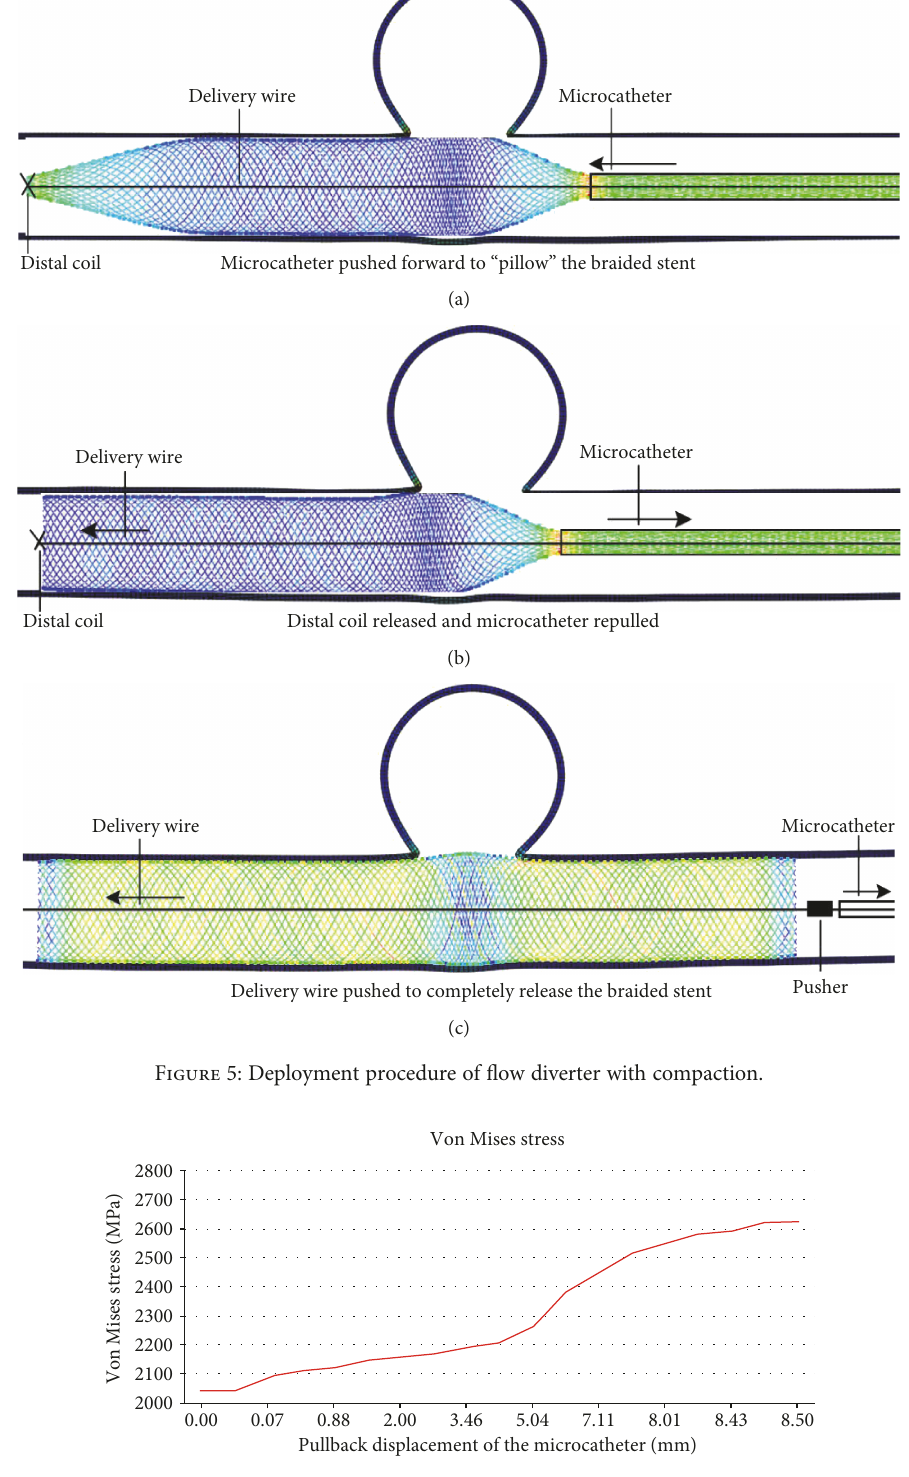
Figure 6: Von Mises stress of the stent (with